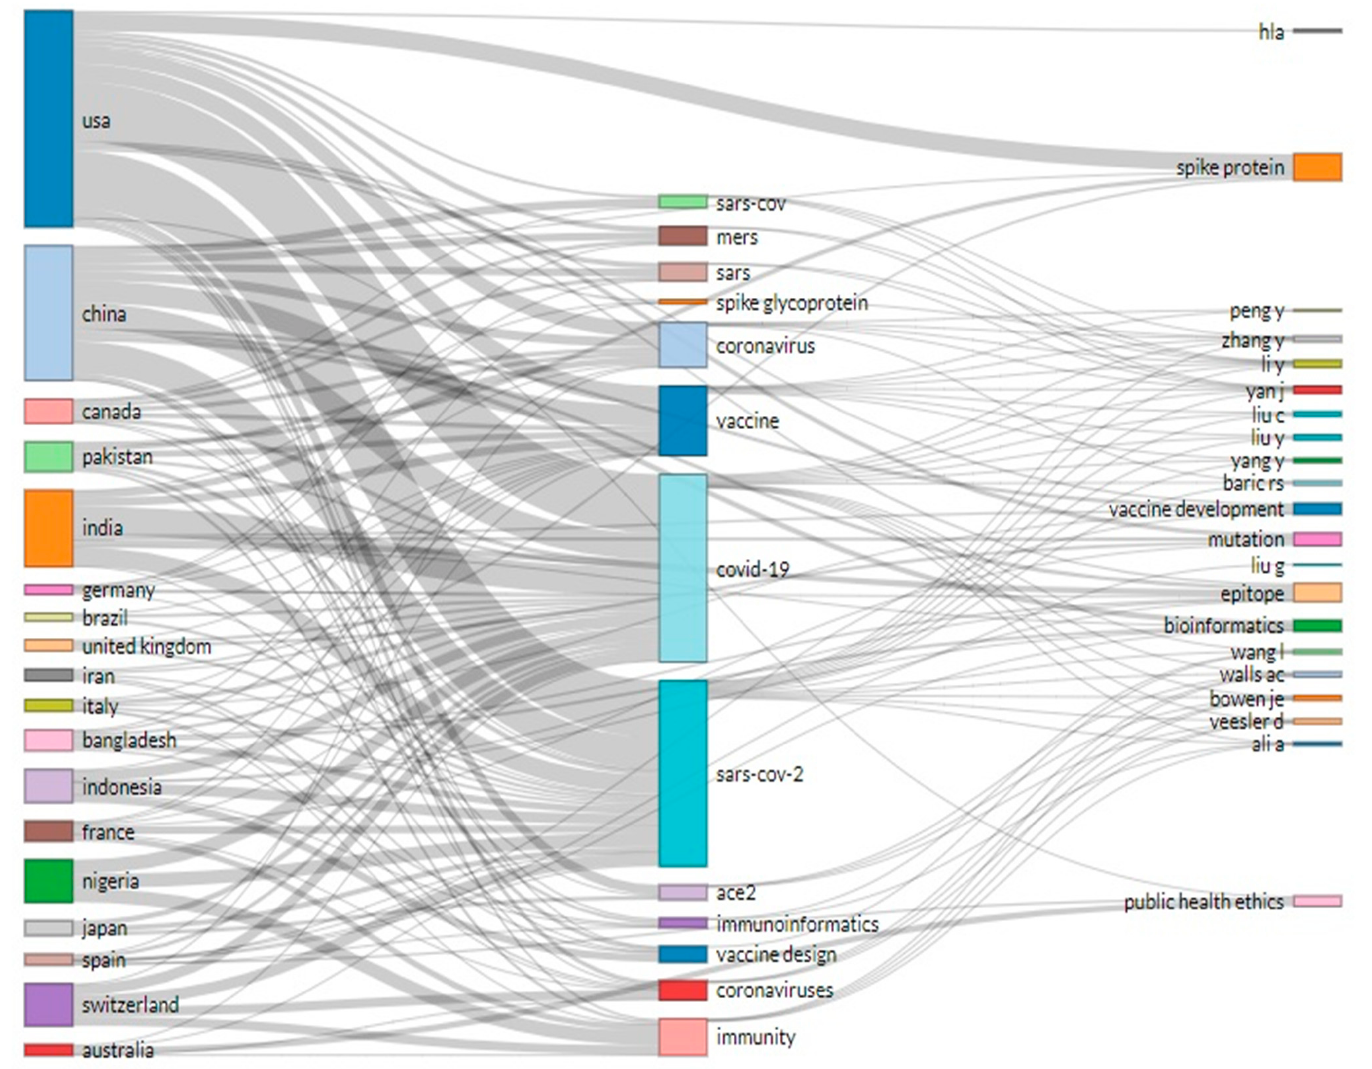
Figure 14. Countries’ contribution in VSCM during COVID-19.